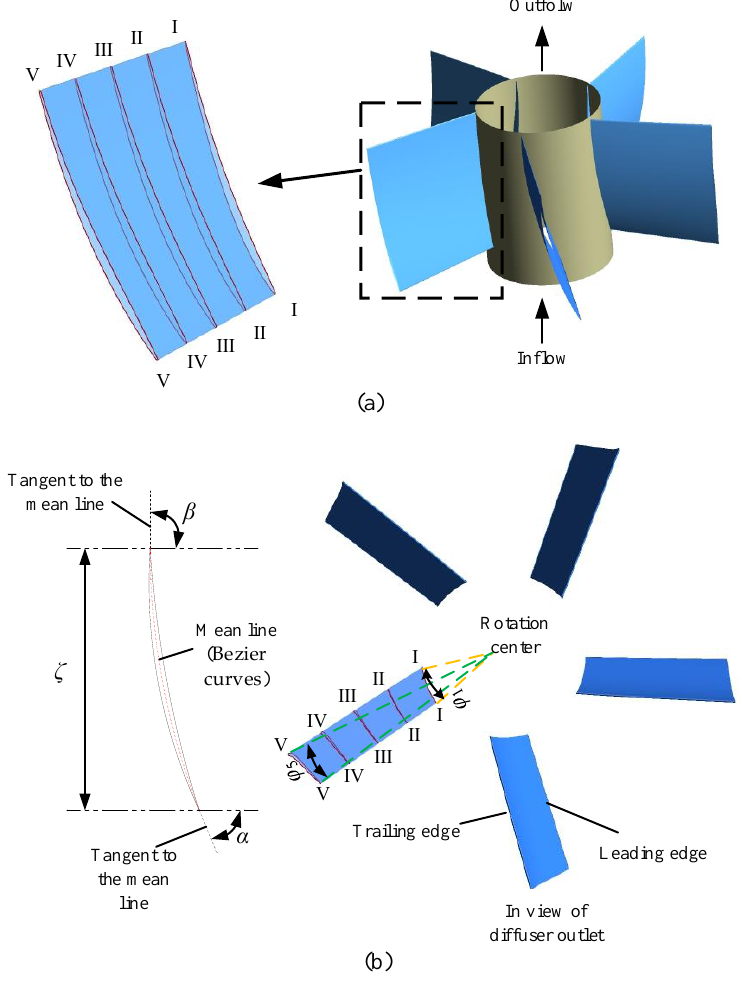
Figure 7. The definition of the main geometry variables of the diffuser: ( a ) definition of the airfoil section and ( b ) main geometry variables of the airfoil.